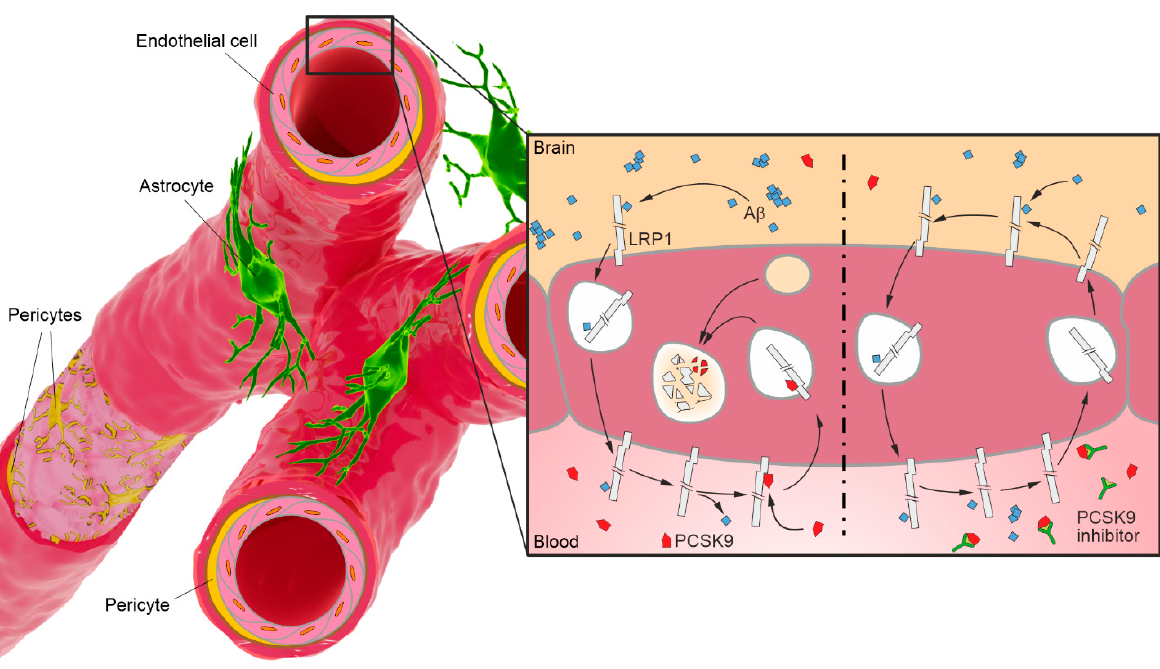
Figure 2. Simplified model of the PCSK9-regulated A β transcytosis across the BBB, mediated by LRP1, and its inhibition via monoclonal antibodies. Left panel: Low-density lipoprotein receptor- related protein 1 (LRP1) binds to cerebral amyloid- β (A β ) and initiates its translocation into the vascular system across the blood–brain barrier (BBB) along its concentration gradient. Secreted PCSK9 in the brain and periphery binds to LRP1 at the endothelial cell surface and targets the receptor for lysosomal degradation, reducing the amount of available A β clearance receptors in the microvasculature. Right panel: The peripheral application of monoclonal antibodies targeting circulating PCSK9 diminishes the number of PCSK9 molecules capable of binding to LRP1, which increases the amount of LRP1 recycled back to the cell surface and consequently the rate of A β transcytosis from brain to